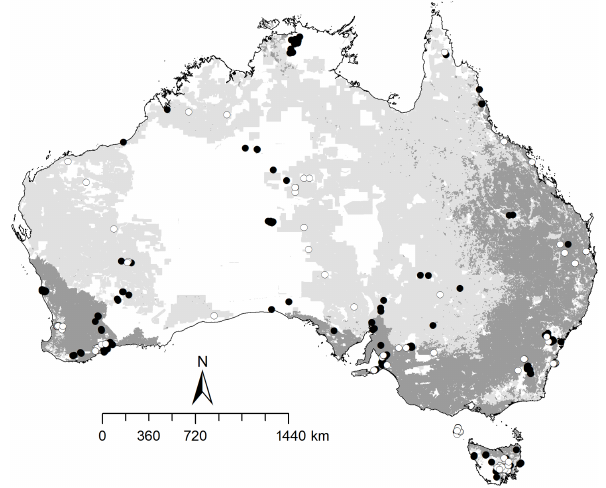
Figure 1. Location of 469 sampling sites across Australia, indi- cated with open circles for soils used for dryland and irrigated crop- ping and from improved and native pastures used for animal grazing (160 sites), and closed circles for soils from areas that are conserved and in natural environments outside of the agricultural production zones (309 sites). The dark grey area represents intensive agricul- tural and plantation production. The light grey area represents agri- cultural production from relatively natural environments. The white area indicates the non-agricultural